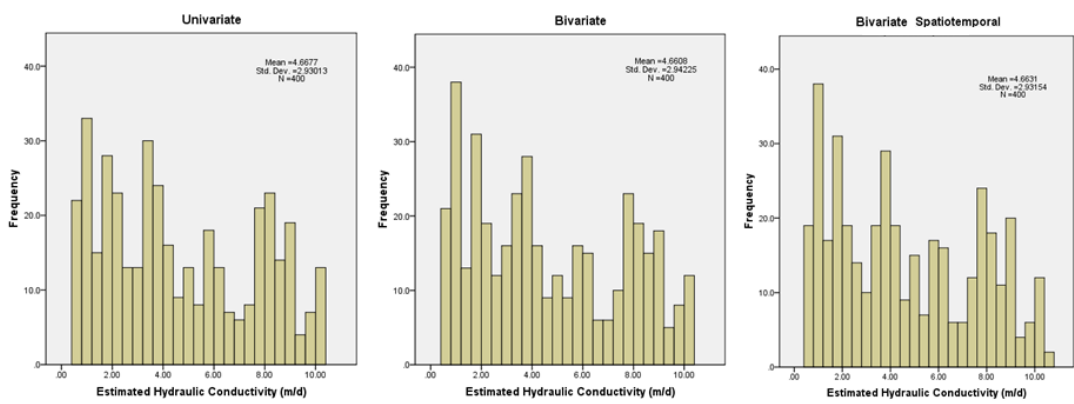
Figure 5. Histograms of hydraulic conductivity estimates.